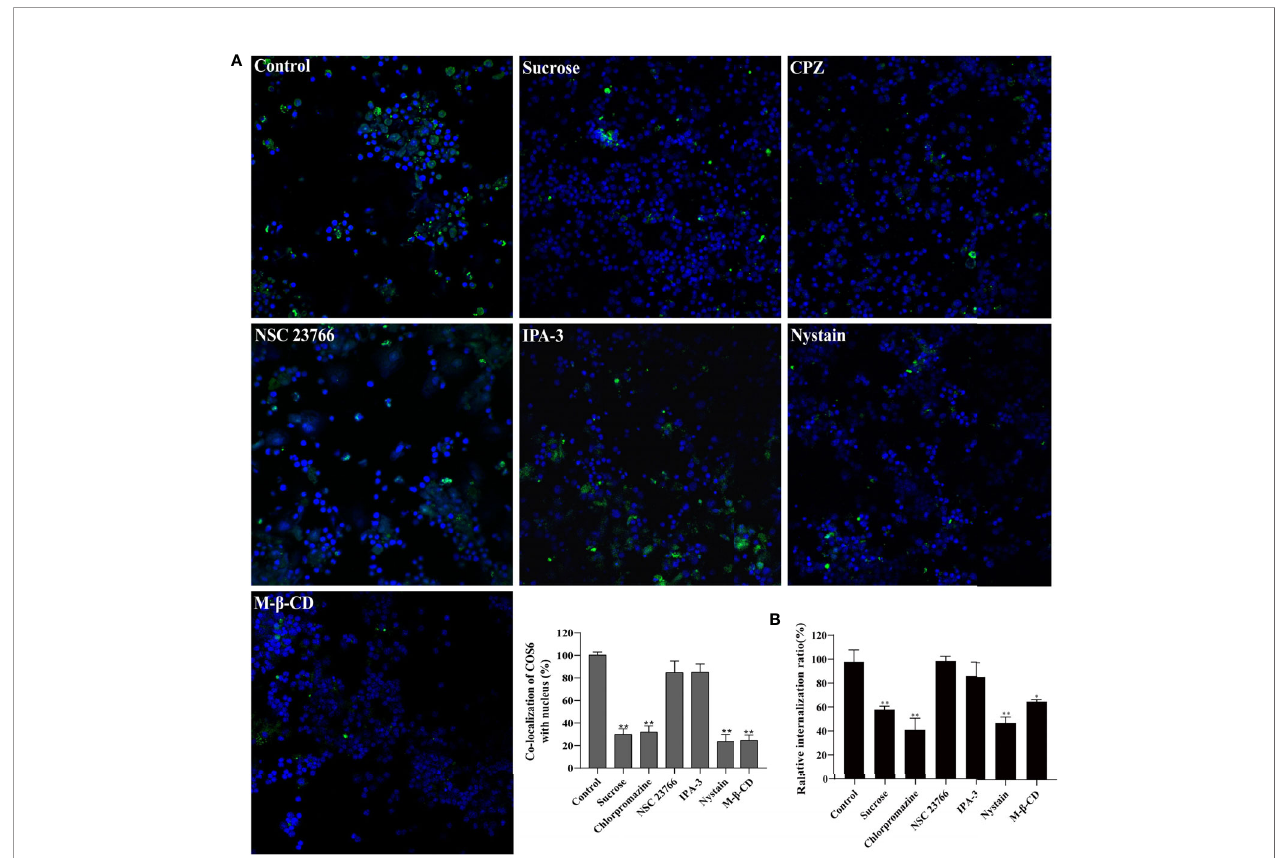
FIGURE 5 | Effect of endocytic pathway inhibitors on chitooligosaccharide hexamer (COS6) uptake by macrophages. (A) Pretreat cells with endocytosis inhibitors or absence (control) and observe the uptake of fl uorescein isothiocyanate (FITC)-COS6 by macrophages under a confocal microscope. The co-localization percentage of FITC-COS6 and nucleus was analyzed using WCIF ImageJ software. (B) Cells were treated with endocytosis inhibitors and incubated with FITC-labeled COS6, washed, lysed, and mixed uniformly. Fluorescence intensity was measured. Data were shown as means ± SD (n = 3), with (*) p < 0.05 and (**) p < 0.01 vs. the control group (set as 100). Scale bar: 250 m